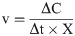
Effect of the addition of different substrates on the accumulation of each intermediate and product.The highest values of the products per g dry cell weight and per hour were calculated by Eq (2).
v=ΔCΔt×X(2)
where v is the highest value (μmol/g h) of each intermediate or product, △C is the amount of accumulated amount (μmol/L) of the products during the bioconversion, △t is the bioconversion time (h) corresponding to the highest value of each intermediate or product, and X is the amount of cells in dry cell weight (g/L). The amount of the added substrates were 111111.11 μmol/L (Glu), 13000.00 μmol/L (Leu), 7000.00 μmol/L (Phe), 5000.00 μmol/L (Tyr), 1500.00 μmol/L (Ca), and 1000.00 μmol/L (pC) respectively. The bioconversion medium contained 833.33 μmol/L glucose. Values in each figure are the mean of three replications and shown with standard deviation. Different letters in the figure indicate the data were significantly different at the level of p<0.01 in Tukey test.